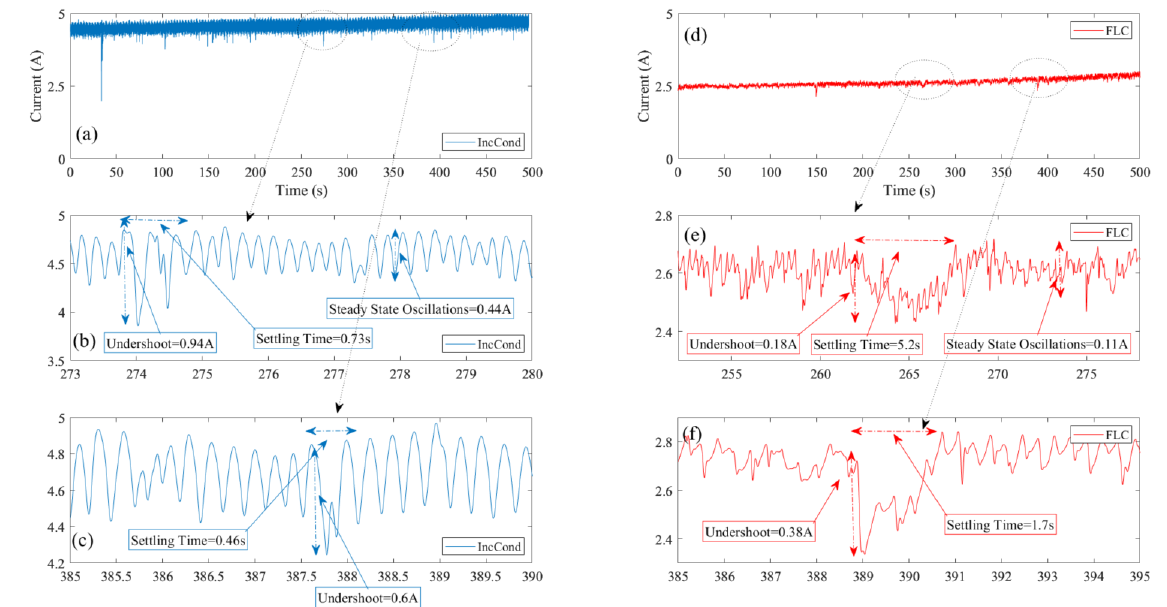
Figure 8. PV panel current signals correspond to the maximum power point: ( a ) current signal under the use of the IncCond; ( b ) influence of the first load variation for the case of the IncCond; ( c ) influence of the second load variation for the case of the IncCond; ( d ) current signal under the use of the FLC; ( e ) influence of the first load variation for the case of the FLC; and ( f ) influence of the second load variation for the case of the FLC.